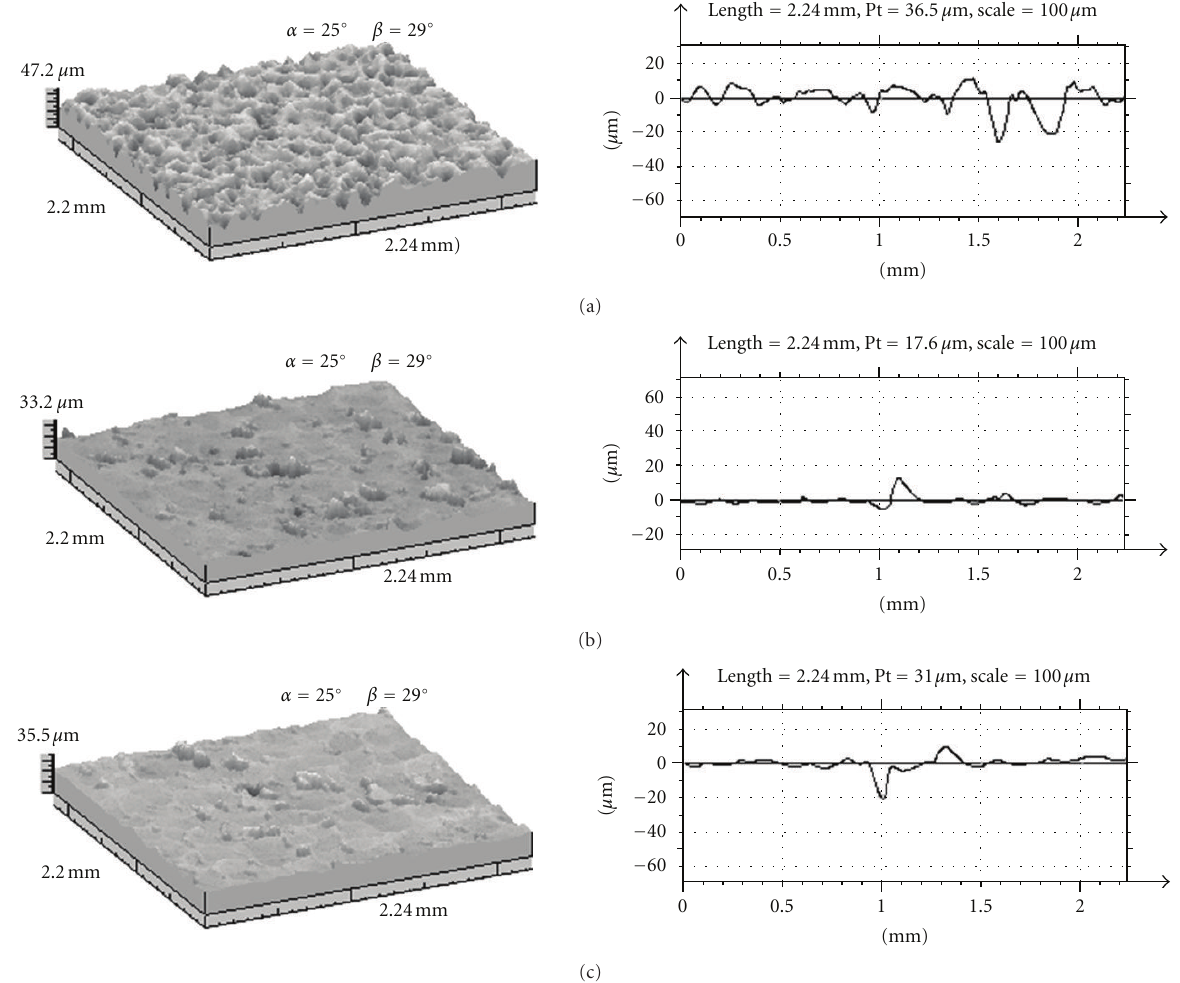
Figure 5: Stereometric image of surface after machining and its profilogram (a) the EDM − U = 160 (V), I = 6(A), Ti = 100( μ s), and the following roto-peen (b) n = 6500 (rev/min), t = 2 . 5 (min), (c) n = 6500 (rev/min), t = 5(min).